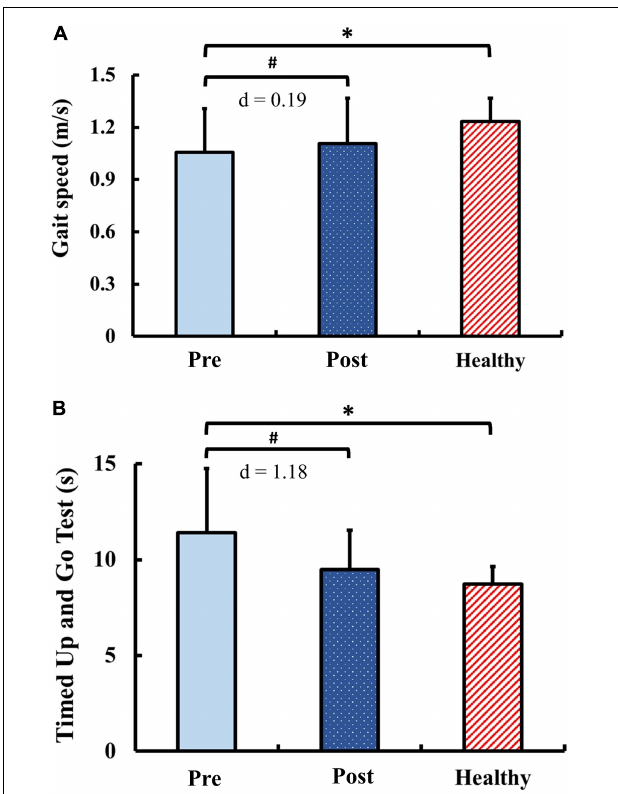
FIGURE 7 | Results for functional performance: (A) gait speed and (B) Timed Up and Go Test. The symbol “ ∗ ” indicated a significant difference between the DCM group and the healthy control group: p < 0.05. The symbol “#” indicated a significant difference in the DCM group before and after training: p <